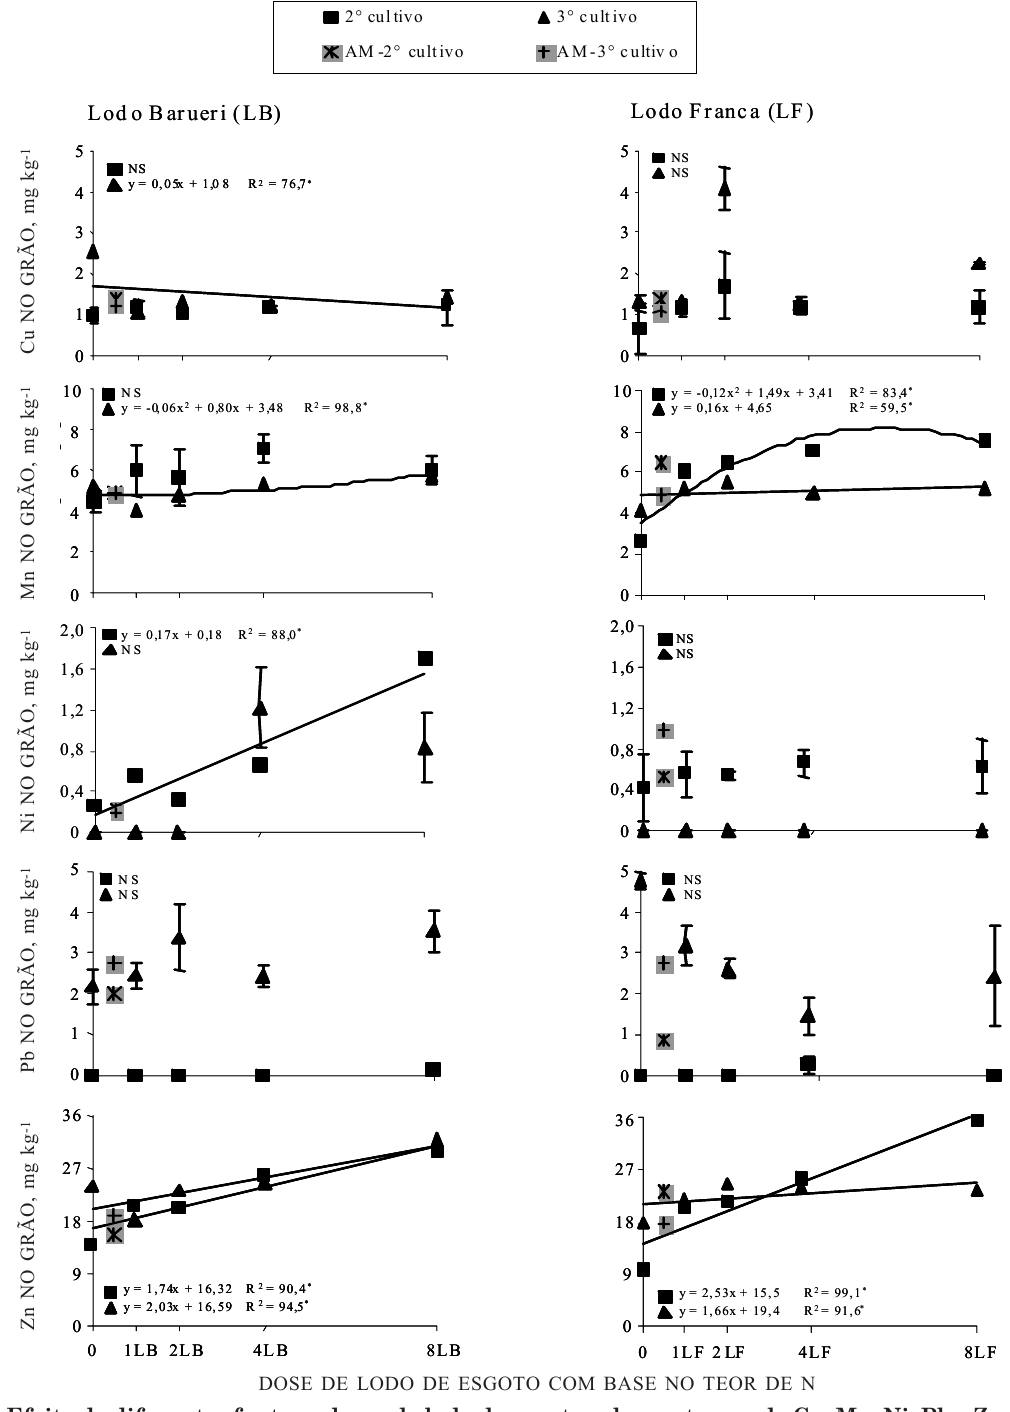
Figura 2. Efeito de diferentes fontes e doses de lodo de esgoto sobre os teores de Cu, Mn, Ni, Pb e Zn em grãos de milho, em dois cultivos consecutivos (* Modelo ajustado significativo a p ≤≤≤≤≤ 0,05, pelo teste F; NS - não- significativo; AM = adubação mineral com NPK recomendada para a cultura do milho). As barras verticais referem-se ao desvio-padrão da